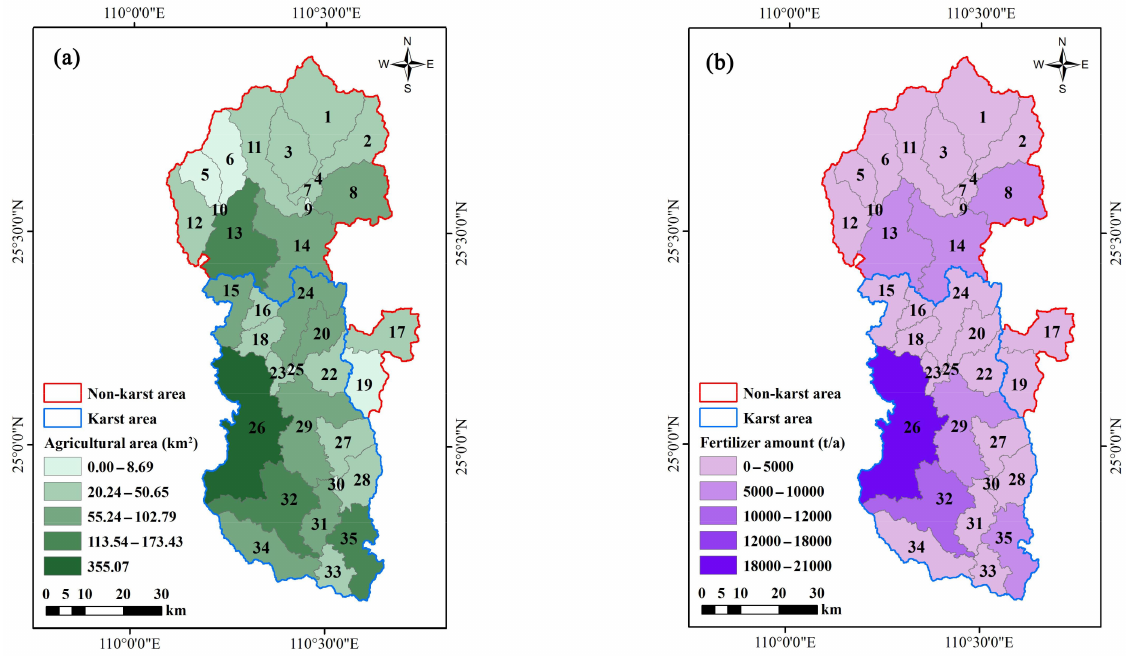
Figure 9. Maps of the distribution of ( a ) cultivated land (km 2 ) and ( b ) fertilization (t/a) in each